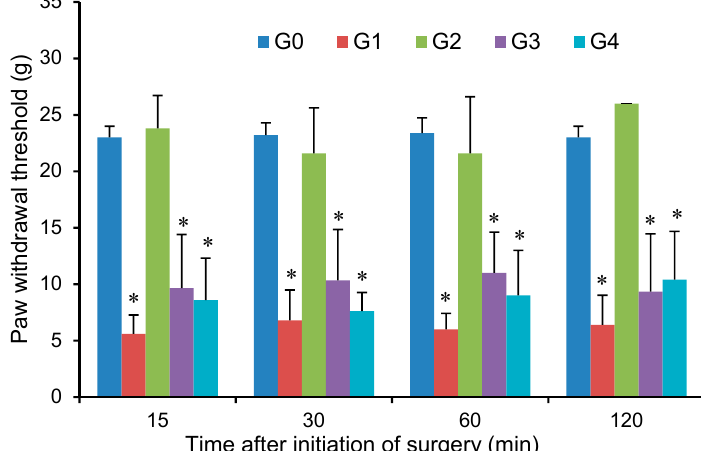
Figure 5. Mechanical pain sensitivity indicating by paw withdrawal threshold (PWT, Von Frey test) among different groups. G0, no treatment; G1, topical application of blank hydrogel + iontophoresis; G2, topical application of FBF hydrogel + iontophoresis; G3, topical application of a marketed FBF hydrogel patch (cataplasms) and G4, oral administration of FBF suspension. n = 6; * P < 0.05 compared with the baseline of G0 group.